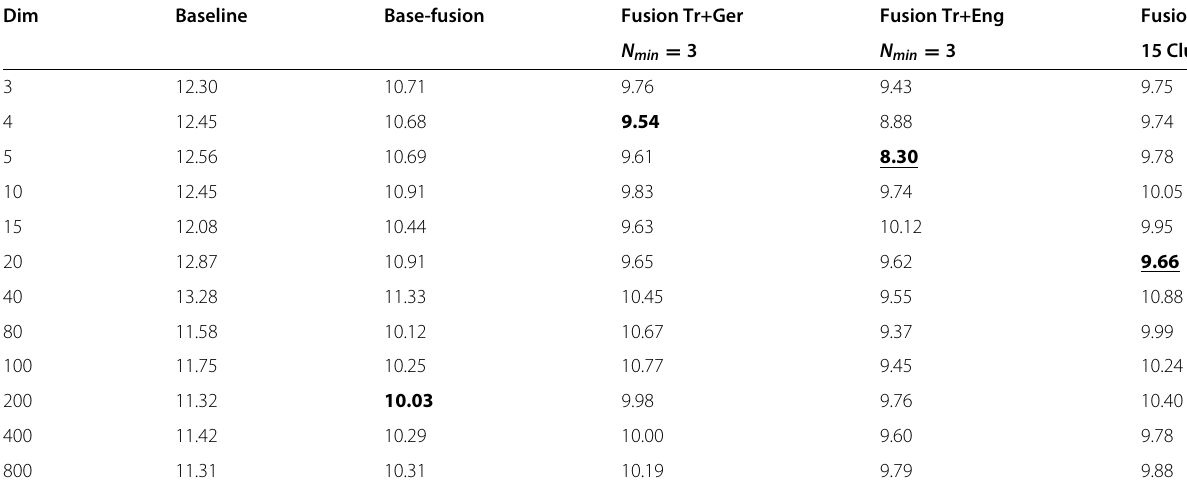
Table 10 Regression results after fusing with text classification. Turkish database was used since transcriptions are not available in the required for the other databases. Baseline acoustic system predictions are used in base-fusion. Bold results show cases where the improvement is significant compared to the baseline case but not to the base-fusion case. In the underlined bold case, improvement is significant both compared to the baseline system and the base-fusion system